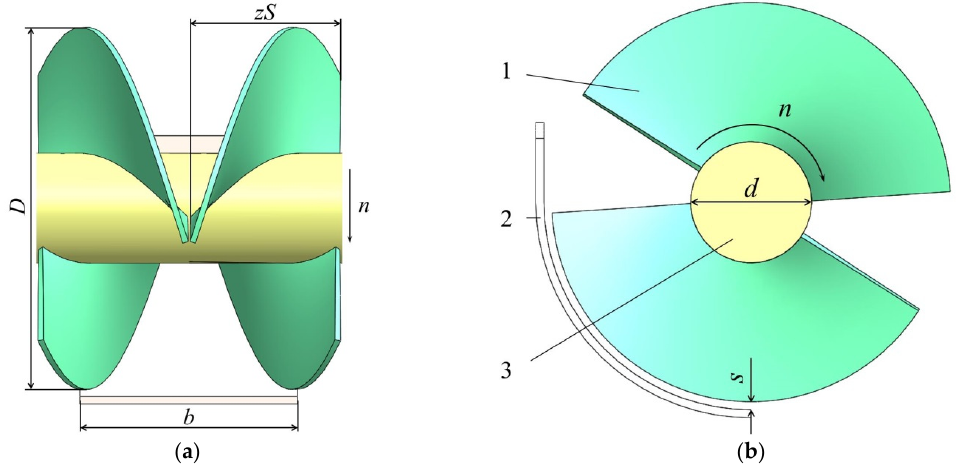
Figure 3. The critical parameters of SSM. ( a ) Main view; ( b ) side view. Note: 1, SRB; 2, straw hopper; 3, spiral shaft; D is the the outer diameter of the row-sorting blade (ODRB), mm; n is the RVSS. rpm; b is the width of the straw hopper, mm; d is the diameter of the spiral shaft (DSS), m; S is the pitch of the spiral blade, m; z is the number of turns of the RB, z ≥ k ; s is the gap between the RB and the straw hopper, m.